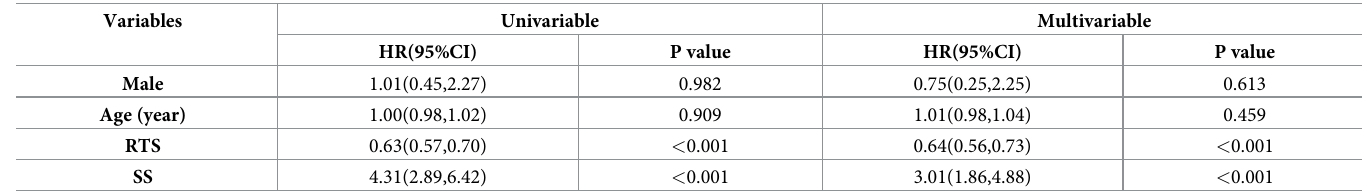
Our study identified SS as an independent mortality predictor of trauma patients in the ED. It could be a better choice than shock index for assessment and triage of trauma patients in the ED. Table 2. Cox regression